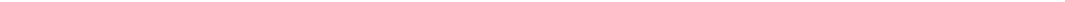
Fig. 2 UBXN3B is critical for STING-dependent IFN-I induction in mouse primary cells. a ELISA of IFN- α in the cell culture supernatants of ( Ubxn3b + / + , Ubxn3b − / − ) bone marrow-derived macrophages (M ϕ ), Flt3-induced pDCs, and GM-CSF-induced cDCs (pooled from fi ve littermates) 20 h after the indicated treatments. N = 3 per genotype. * P < 0.05 (unpaired Student ’ s t test). b Immunoblots of an interferon-stimulated gene Oas1a, Sting, and Ubxn3b expression in cDCs 20 h after the indicated treatments. Tubulin is a housekeeping protein control. qPCR analysis of ( c ) Ifnb1 and Tnfa mRNA expression and d cellular HSV-1 genome loads in cDCs infected with HSV-1 (MOI = 10) for the indicated time. e Immunoblots showing Ubxn3b and housekeeping Gapdh protein expression in mock ( Ubxn3b + / + ) or 4-hydroxyl tamoxifen-treated Cre + / − Ubxn3b fl ox/ fl ox ( Ubxn3b − / − ) MEFs. f Viral titers (plaque-forming units/ml) in the supernatant of MEFs infected with HSV-1 (MOI = 0.1). N = 3 per genotype per time point. * P < 0.05; ** P < 0.01 (unpaired Student ’ s t test). g qPCR analysis of selected immune gene mRNA expression in MEFs infected with HSV-1 as in g . h The immunoblots show knockout ef fi cacy of STING and UBXN3B by CRISPR-Cas9 in human primary trophoblasts. Actin is a housekeeping protein control. i Fluorescent microscopic images of human primary trophoblasts infected with HSV-1-GFP (MOI = 0.3) for 18 h. Objective, ×5. Scale bar, 10 µ m. j qPCR analysis of Ifnb1 mRNA expression in human primary trophoblasts infected with HSV-1-GFP for the indicated time. Bars/data points: mean ± s.e.m. Two biological replicates were pooled for qPCR ( N = 2 per genotype per time point). * P < 0.05; ** P < 0.01 (unpaired Student ’ s t test). The results are representative of two independent experiments NATURE COMMUNICATIONS| (2018) 9:2329 |DOI: